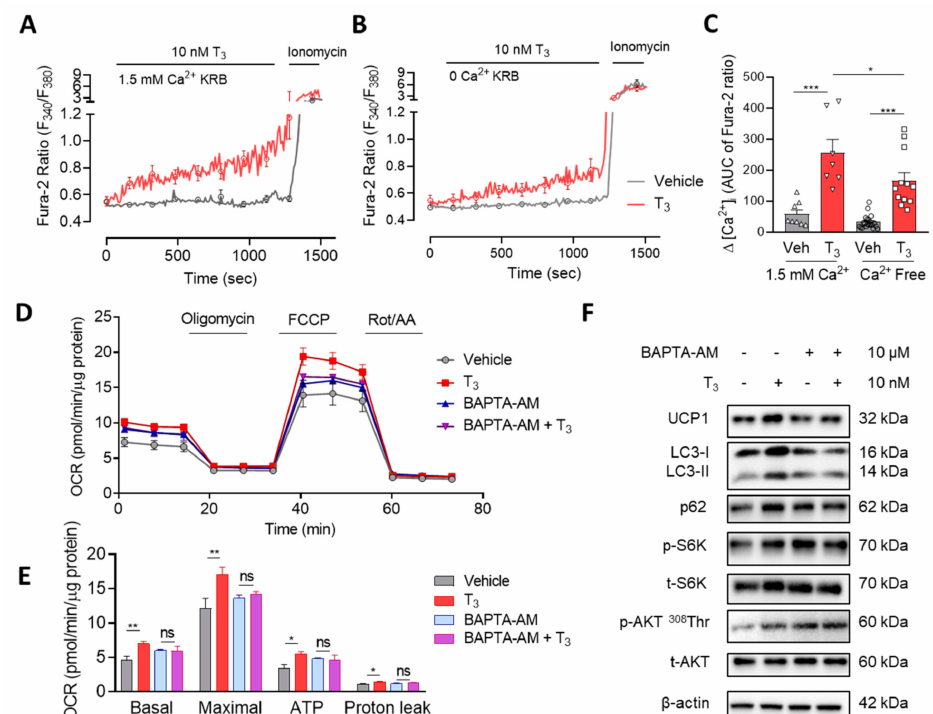
Figure 3. T 3 induces cytosolic Ca 2+ increase and mitochondrial activation. Cytosolic Ca 2+ measure- ment with Fura-2 AM in ( A ) free Ca 2+ and ( B ) 1.5 mM Ca 2+ KRB on immortalized brown adipocytes with direct 10 nM T 3 perfusion. ( C ) Quantitative analysis of [Ca 2+ ] i in free and 1.5 mM Ca 2+ KRB. ( D ) OCR measurement on primary brown adipocytes with 10 µ M BAPTA-AM treatment for 1 h before 10 nM T 3 treatment for 30 min. ( E ) Quantitative analysis of basal respiration, maximal respiration, ATP production and proton leak ( n = 4). ( F ) Western blot of several autophagy-related proteins and mTOR signaling pathway proteins in immortalized brown adipocytes with 10 µ M BAPTA-AM pretreatment for 1 h before 10 nM T 3 treatment for 30 min. Data were presented as mean ± SEM. * p ≤ 0.05, ** p ≤ 0.01, *** p < 0.001, ns not